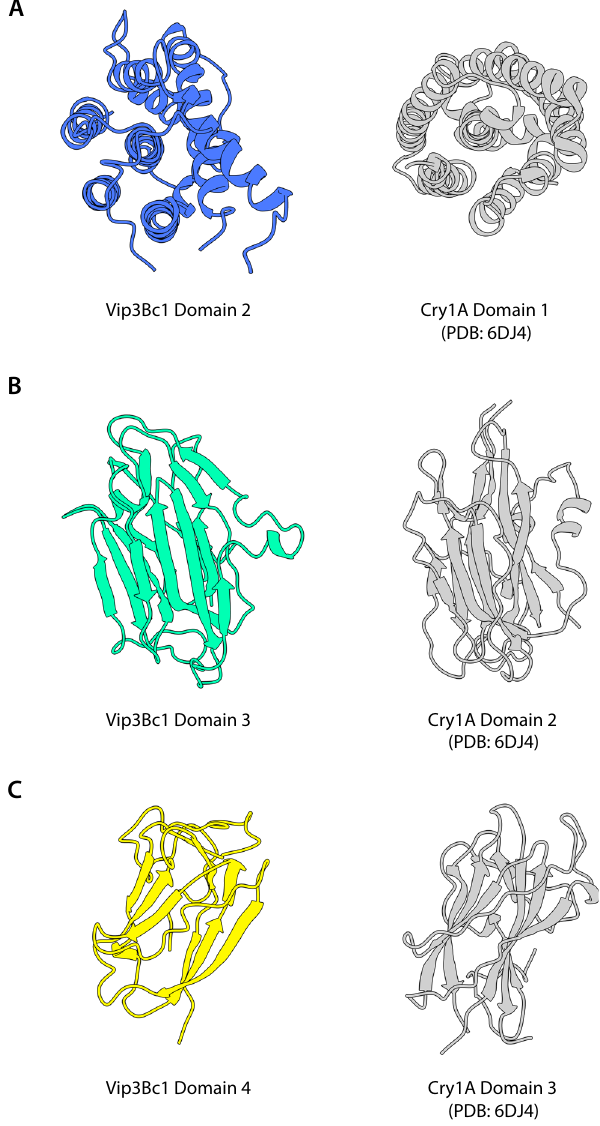
Fig. 4 Structural homology of Vip3 domains to counterpart 3D-cry domain. Structural homology of Vip3 domains to counterpart 3D-cry domain. A Vip3Bc1 domain 2 and 3D-Cry domain 1 (Cry1A domain 1, PDB 6DJ4 shown) share a predominantly hydrophobic alpha helix surrounded